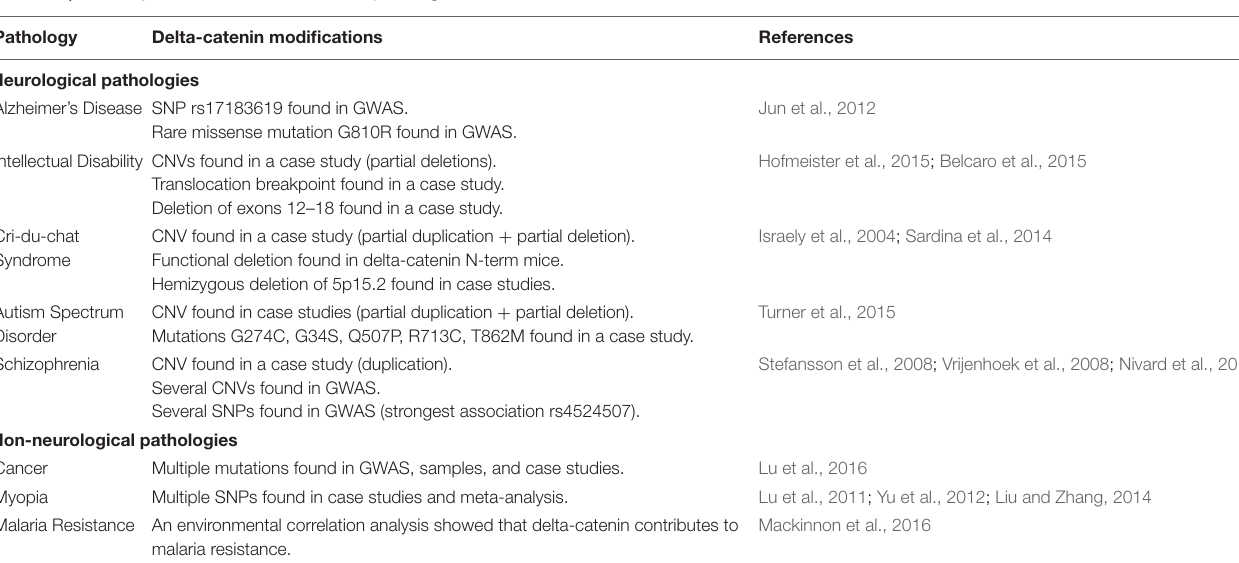
FIGURE 3 | Delta-catenin’s PDZ-binding motif at its C-terminus is essential for shaping dendrite morphology via binding with PDZ-domain proteins. (A) Delta-catenin requires Erbin to bind its PDZ-binding motif for delta-catenin to promote dendritic arborization. In the absence of delta-catenin association with Erbin (e.g., Erbin depletion), delta-catenin cannot localize properly which results in decreased dendrite length and branching. Based on findings from Arikkath et al. (2008). (B) When delta-catenin’s PDZ-binding motif is phosphorylated, delta-catenin favors binding Pdlim5, which promotes dendritic branching. Conversely, when delta-catenin’s PDZ-binding motif is unphosphorylated, delta-catenin has the propensity to bind Magi1, which promotes dendritic lengthening. Based on findings from Baumert et al. (2020). Neuron morphology is not intended to be compared between panels (A,B) , as they are based on findings from separate studies. Created with https://BioRender.com. TABLE 1 | Summary of delta-catenin’s associated